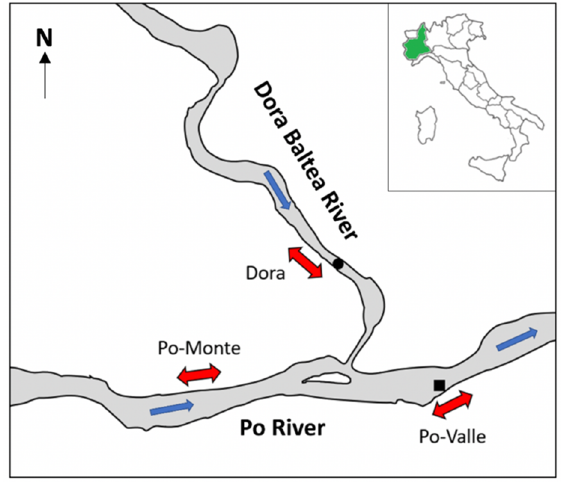
Figure 2. The study area. Double-directional red arrows represent automatic stationary receivers, unidirectional blue arrows represent the river flow direction, the black square the release site of the tagged Wels catfish in the Po River, and the black circle the release site of the tagged marble trout in the Dora Baltea River.